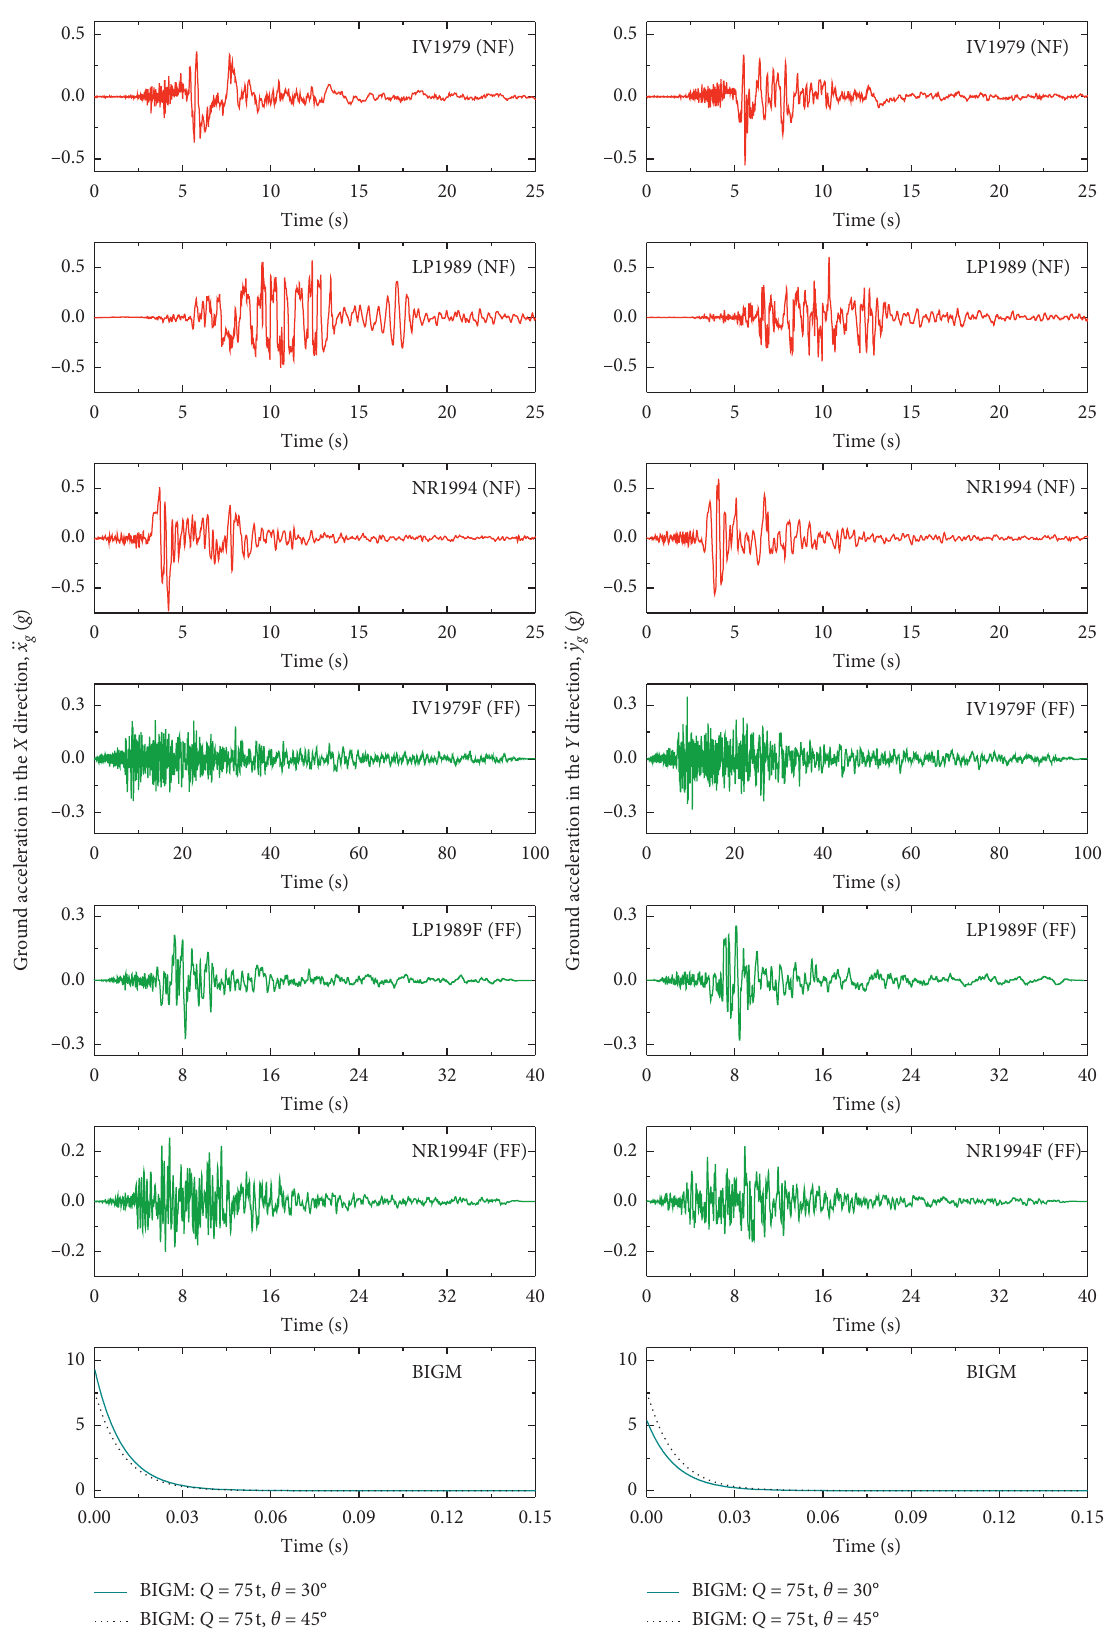
Figure 2: Time histories of NF earthquakes, FF earthquakes, and BIGMs used in the